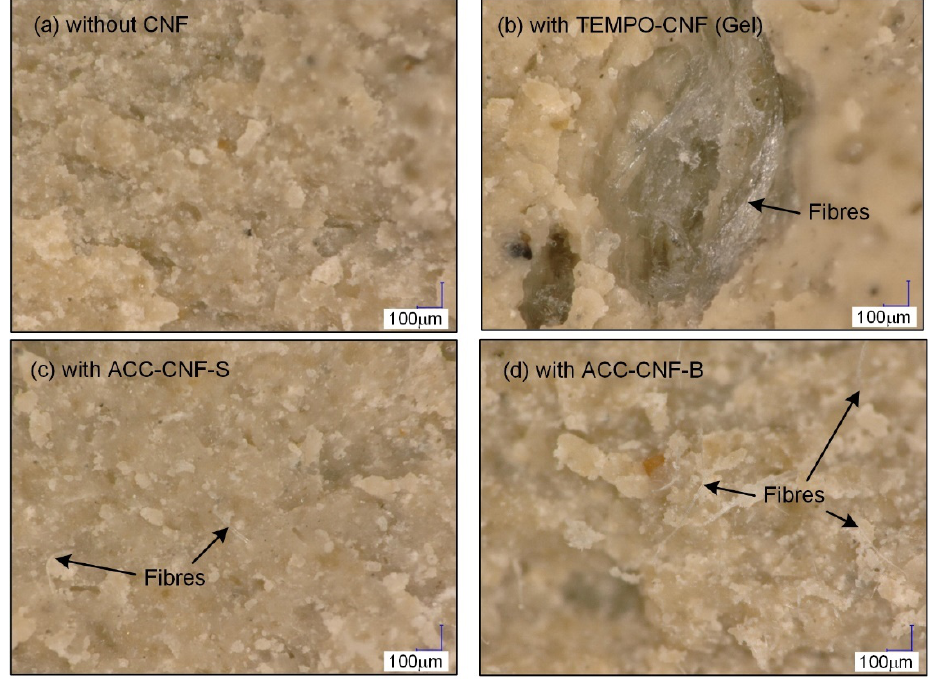
Figure 9. Appearance of tensile fracture surface (Method 1).